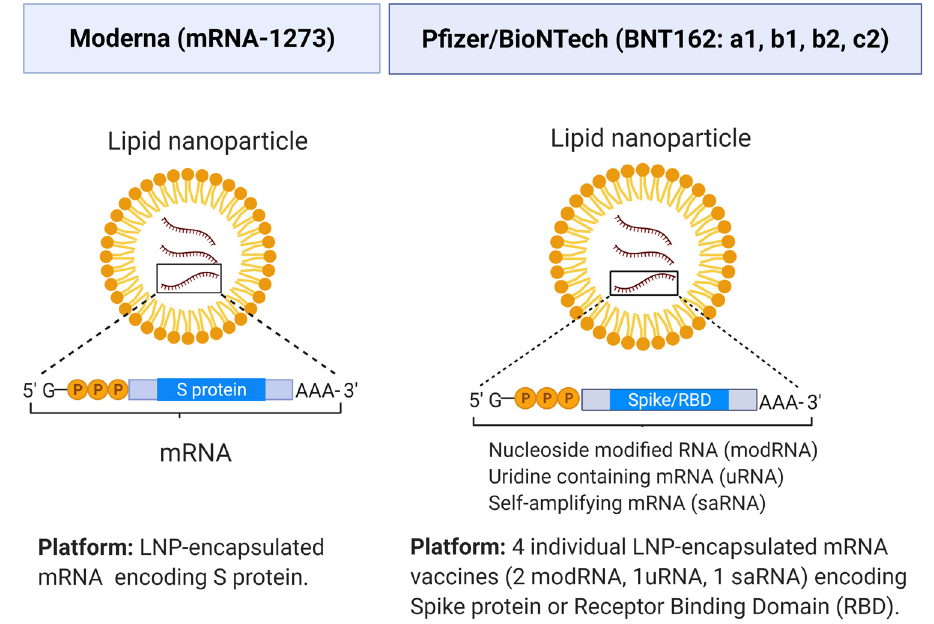
Figure 8: mRNA - 1273 and BNT162 vaccines for COVID - 19